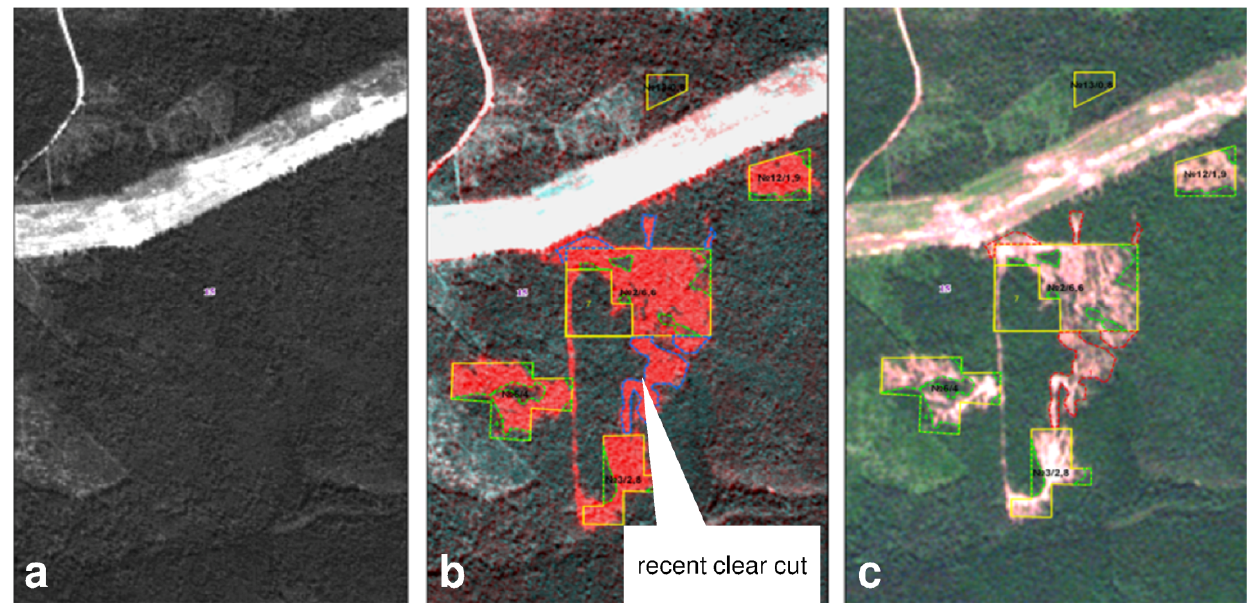
Figure 3. Deforestation change detection based on SPOT-5 Pan ( a : 26 July 2010) and WORLDVIEW-2 ( b : RGB composite of a and c ) satellite data. FI stands affected by forest cover change are indicated in b . The red polygons ( c : 20 June 2011) indicate for cross-comparisons inadequate and disturbed FI stands as the result of the homogeneity